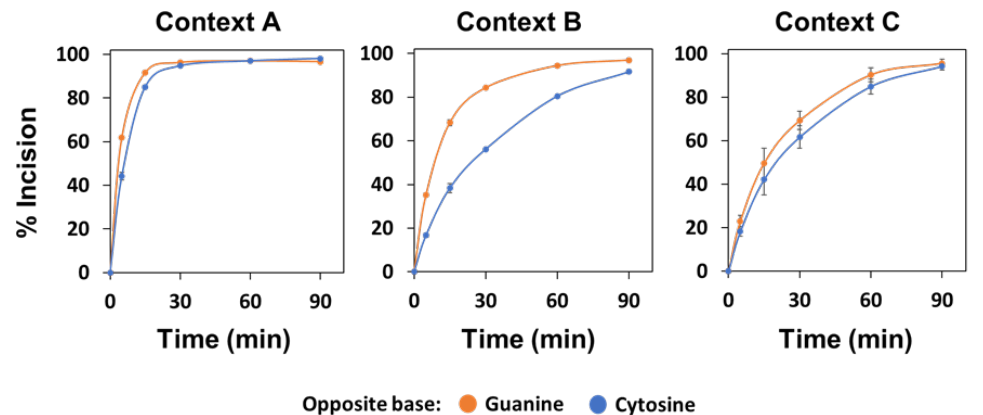
Figure 8. Effect of the sequence context and base opposite to the abasic site on the native AP endonuclease activity. Cell extracts (0.1 μg) from U2OS were incubated at 37 °C with 20 nM DNA substrates (contexts A, B or C). After stabilization with NaBH 4 , the reaction products were separated by denaturing PAGE, detected by fluorescence scanning and quanti- fied. Data are the mean and standard error from three independent experiments.